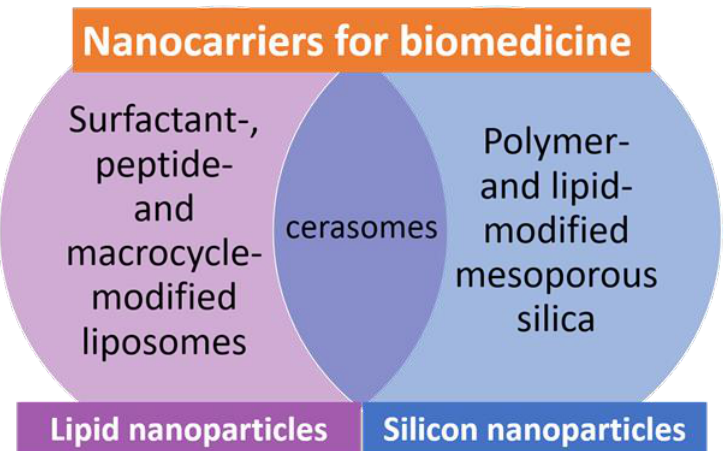
Figure 1. Main types of lipid- and silicon-containing nanoparticles, comprising many kinds of nanocarriers that can be used to achieve the best medical performance.